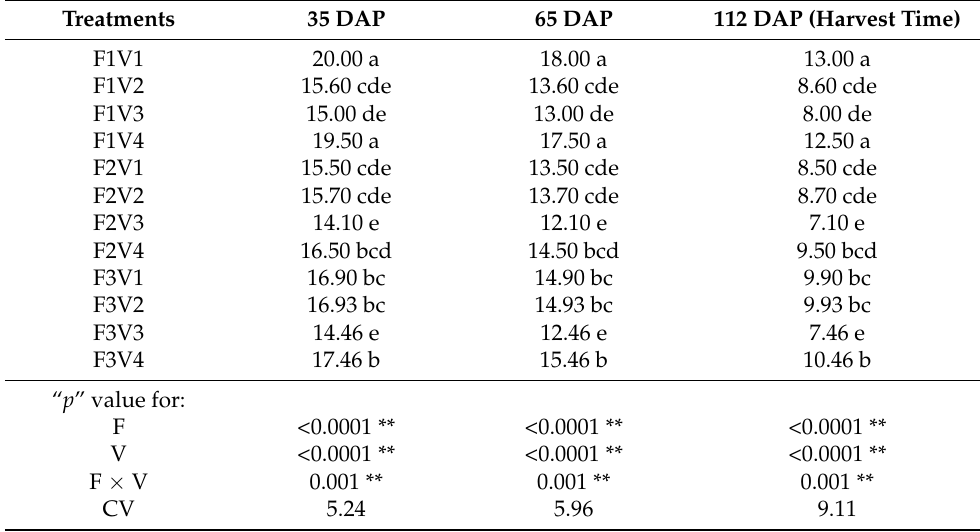
Table 5. Tiller number per plant of the treatments of the study in karst dryland, WS 2019/2020.